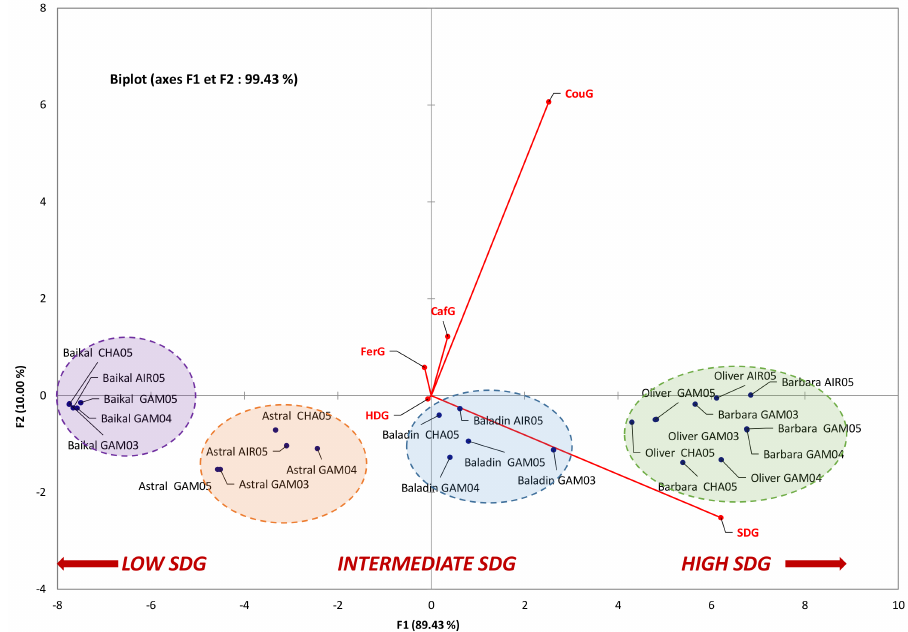
Figure 3. Correlation circle for principal component analysis. The SDG, HDG, CafG, CouG, and